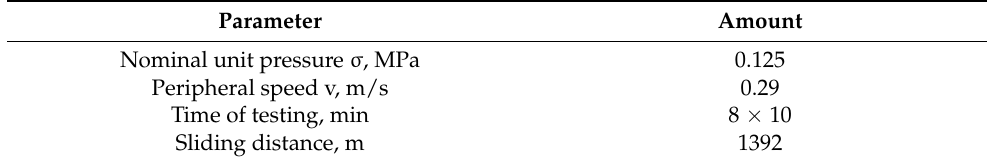
Table 3. Basic parameters of the wear